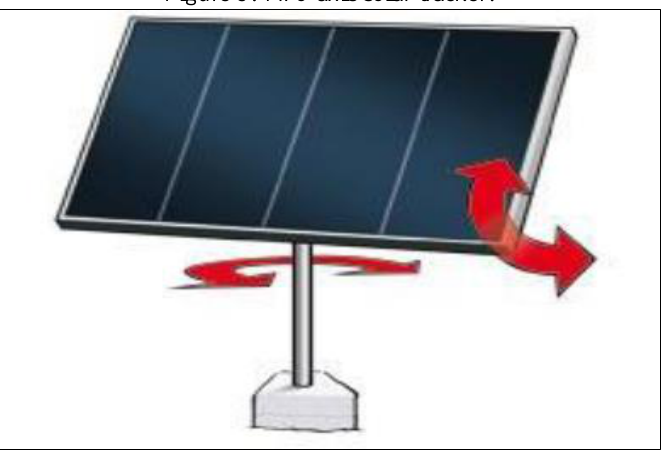
Figure 3: Two-axis solar tracker.